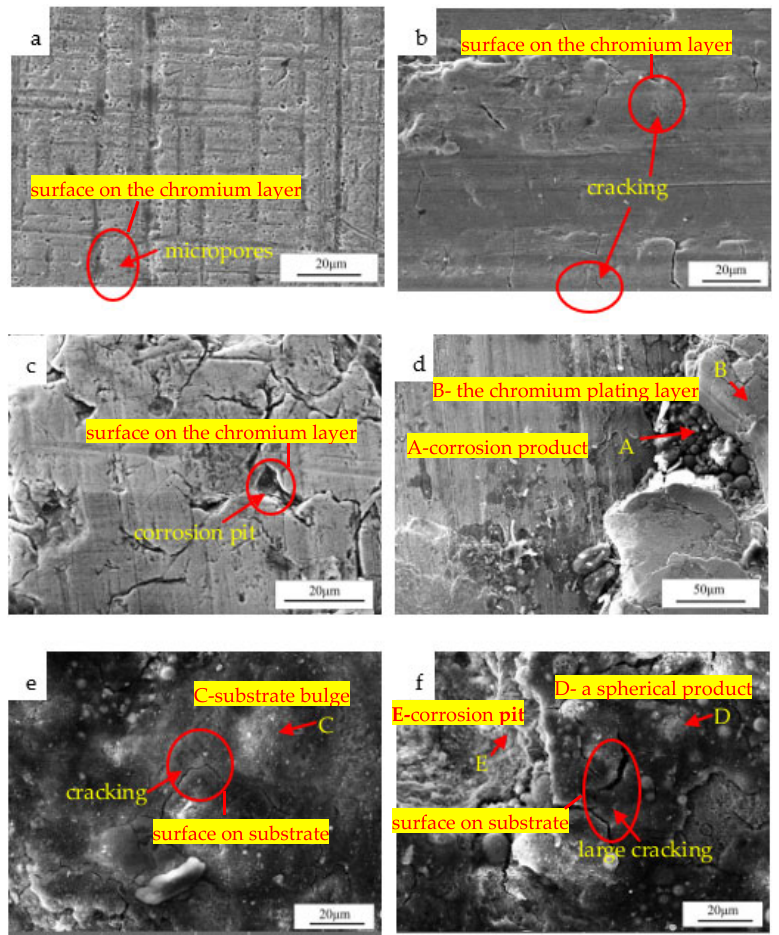
Figure 5. SEM micromorphology observation: ( a ) chromium plating layer; ( b ) cracking; ( c ) corrosion pit; ( d ) peeling of the chromium plating layer; ( e ) exposed substrate; ( f ) corrosion extension. Table 2. Chemical composition of A–E in Figure 5 (wt%).